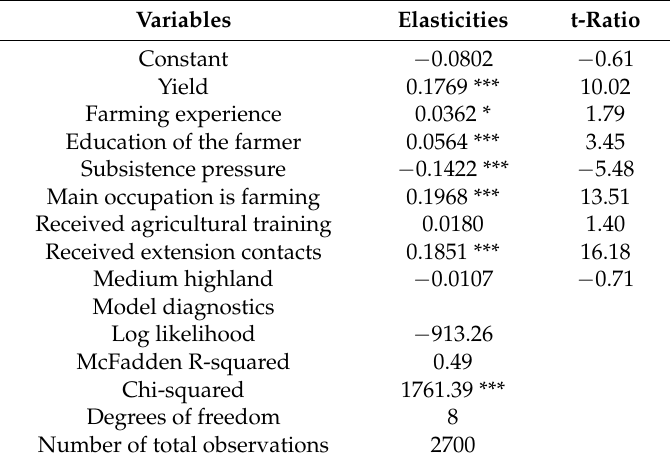
Table 5. Probit elasticities of the factors influencing the decision to adopt improved pulse